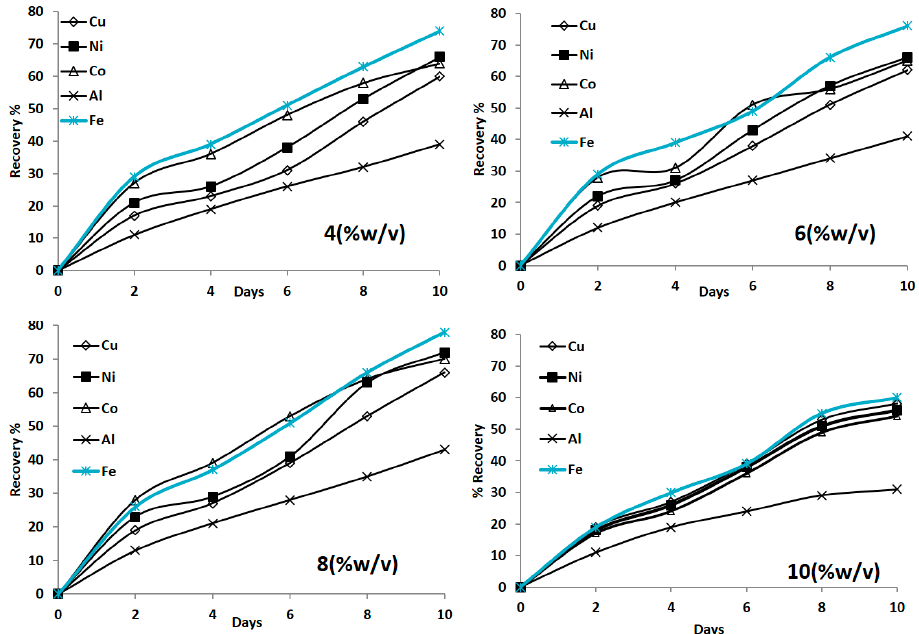
Figure 6. Variation of redox potential during bio-leaching of PCB at the different solid-liquid ra- tios, 308 K and pH 2.0 [( a ) bacterial leaching; ( b ) fungal leaching].